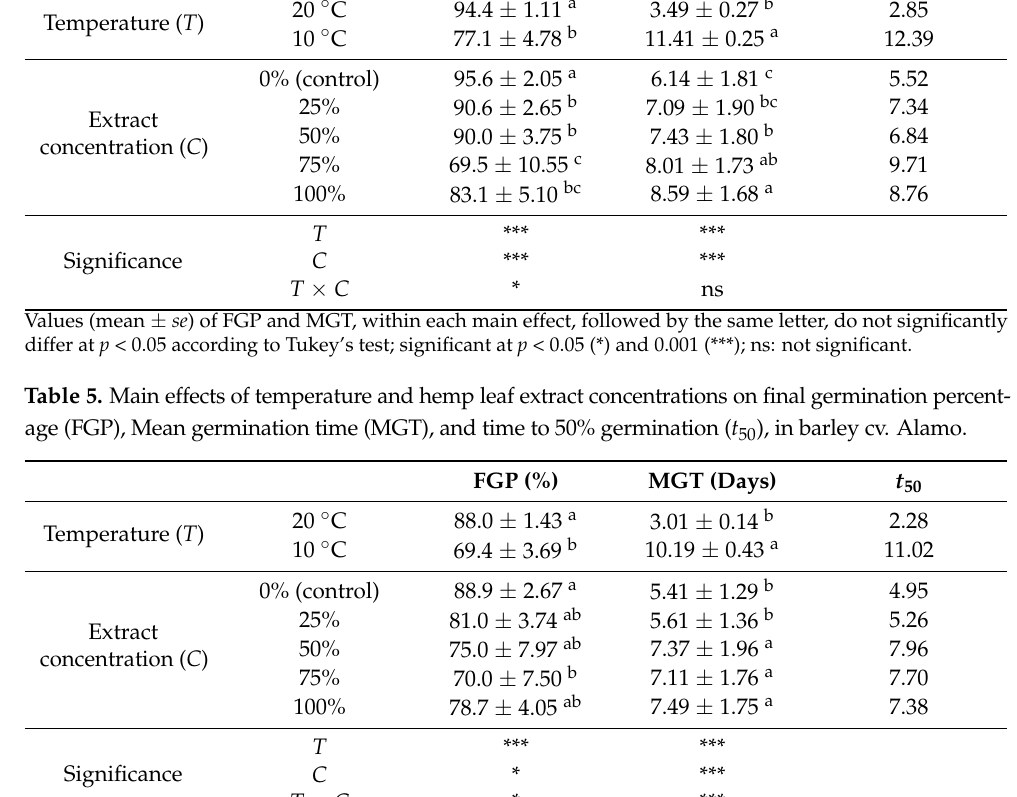
concentration ( C